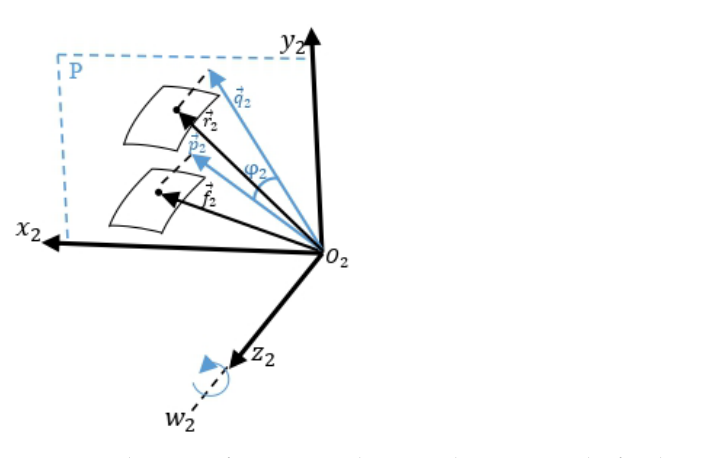
. Figure 2. Schematic of rotation angle φ 2 on plane P around a fixed axis w 2 𝑤𝑤 2